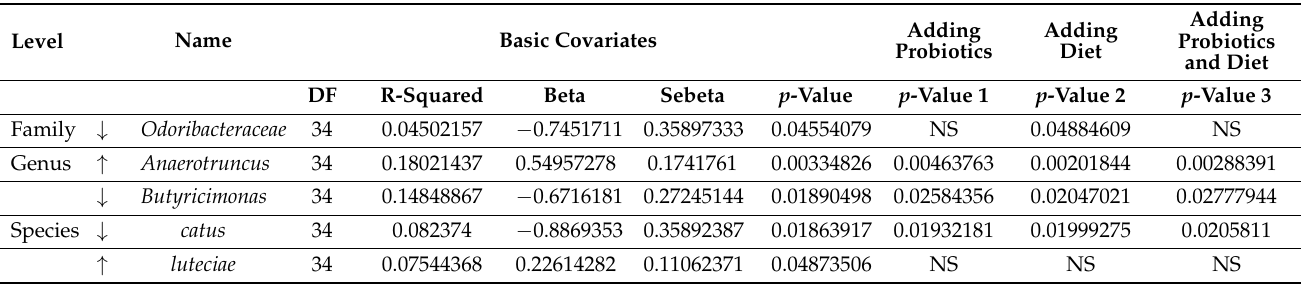
Table 5. Significant relative abundances of bacterial taxa in GID compared to CTRL.